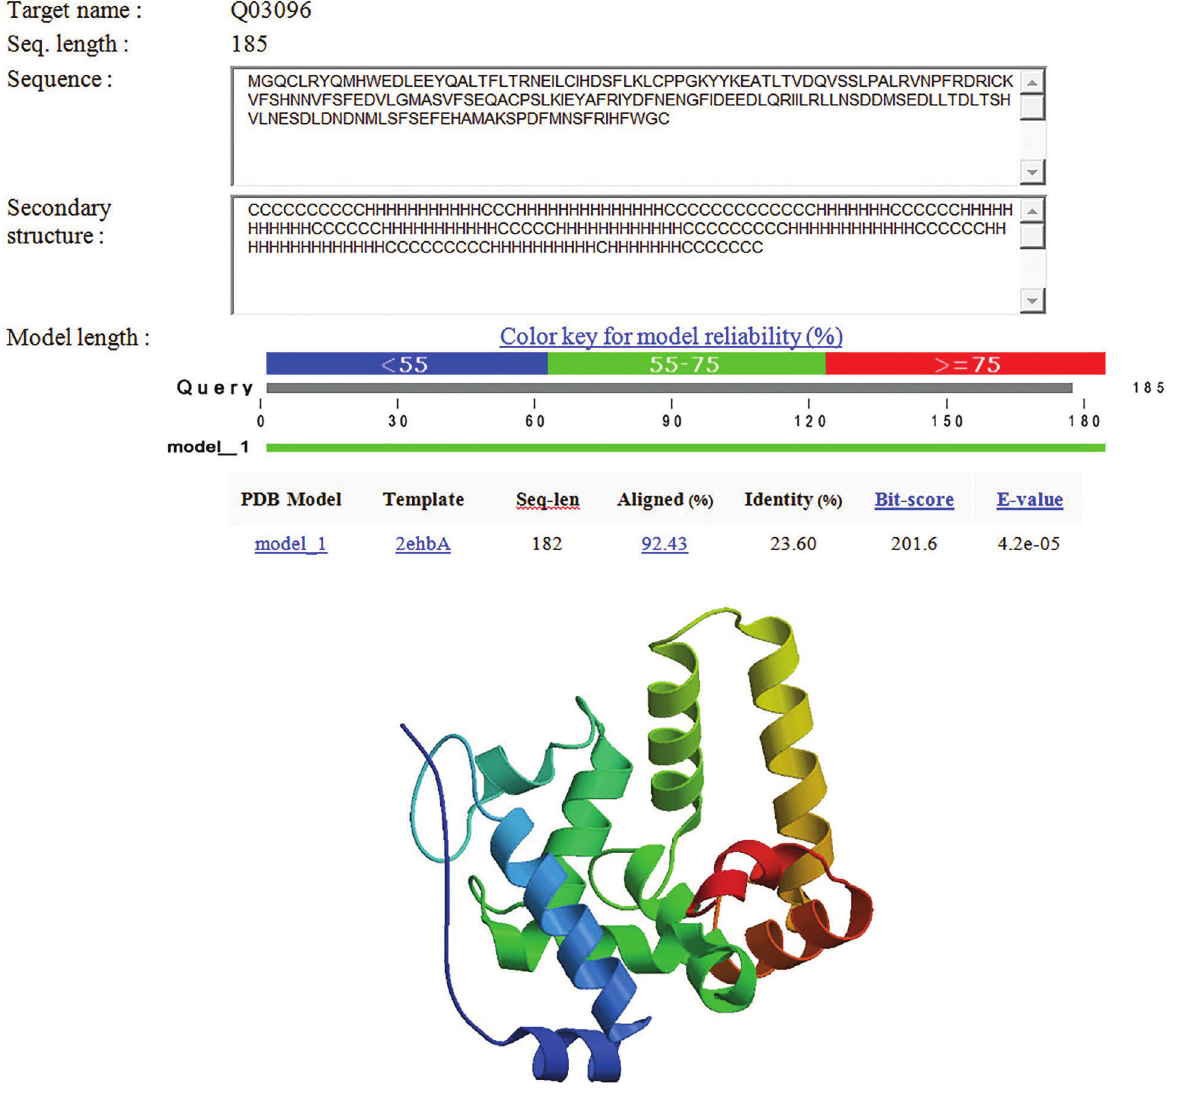
Figure 6. Protein characteristics and three-dimensional structures of CIB 4 for Kermani